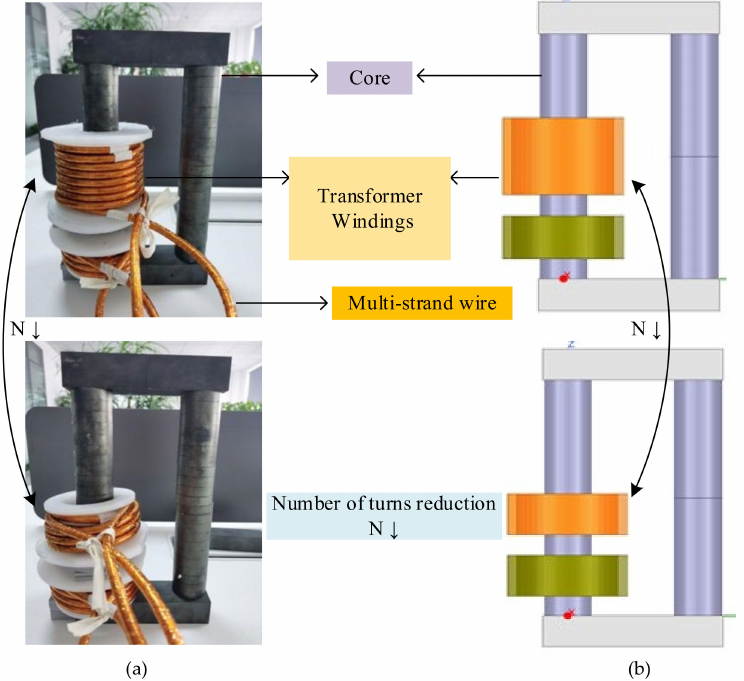
Figure 11. Change in transformer windings with ( a ) real transformer and ( b ) simulation